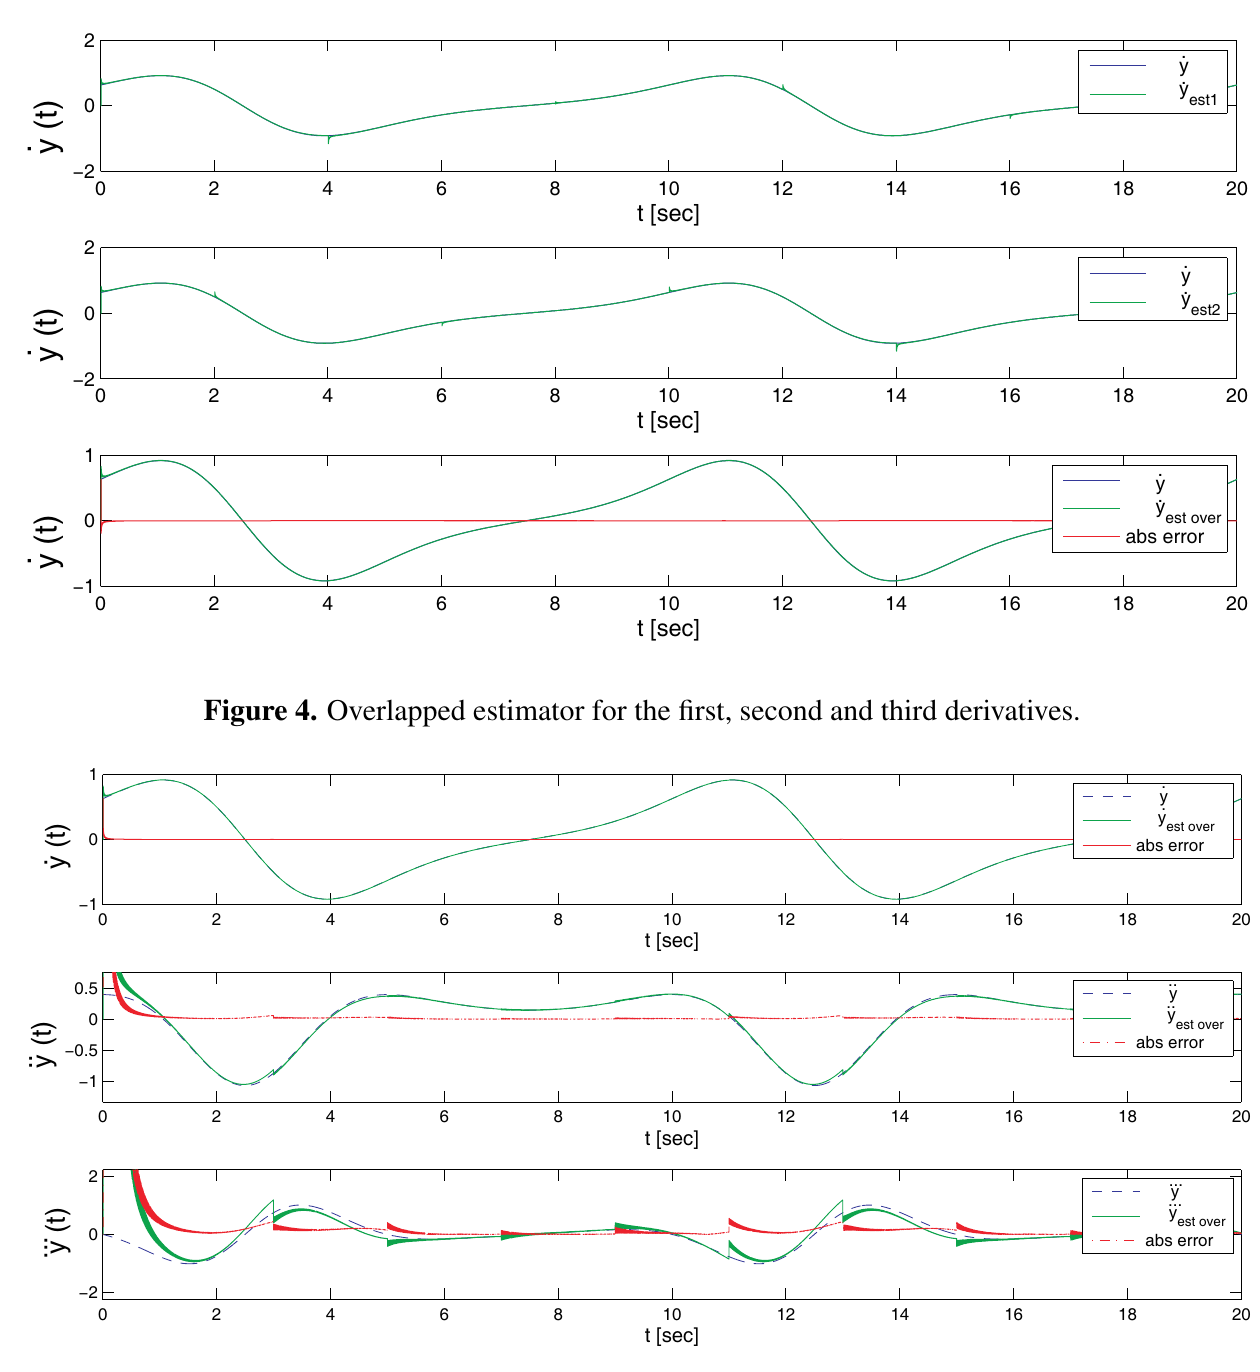
Figure 3. Overlapped estimator for the first derivative.